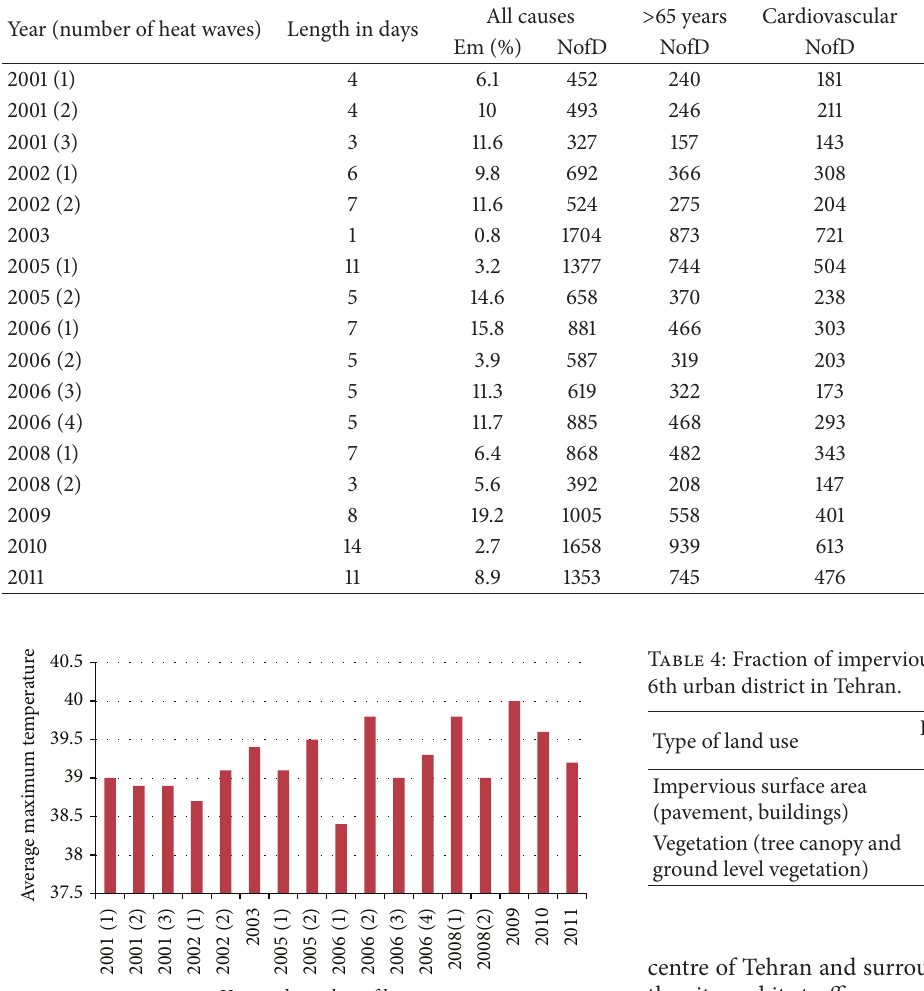
Table 3: Heat waves in Tehran from 2001 to 2011. Em indicates the excess mortality in percent and NofD indicates the number of death from 5 categories: all mortality causes, elderly people ≥ 65 years, with cardiovascular, cerebrovascular, and respiratory causes [32].